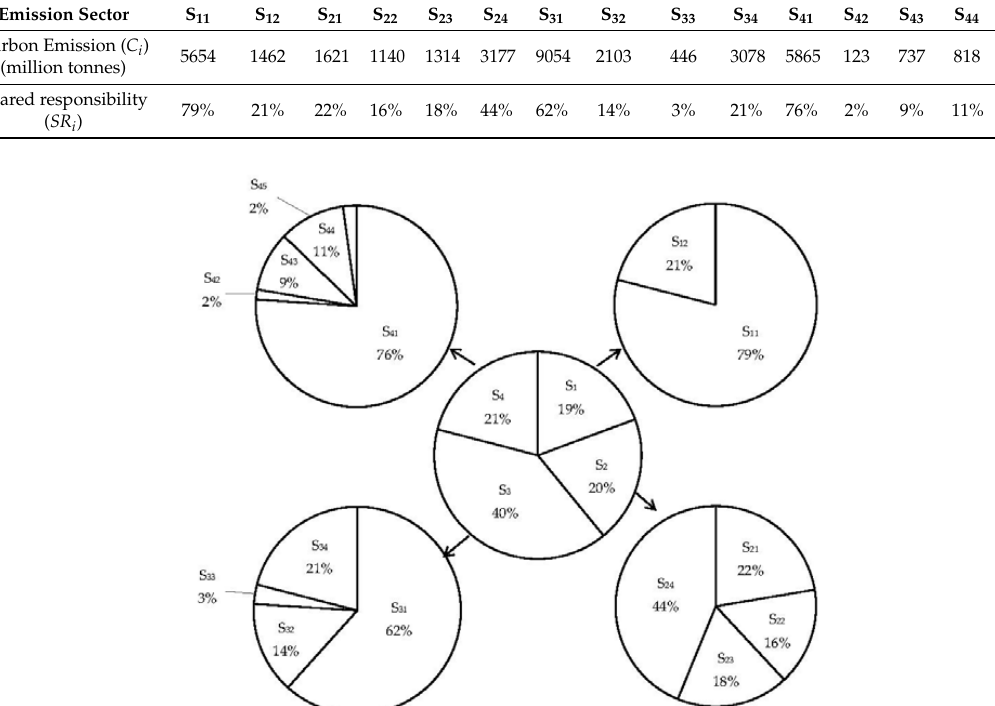
Table 6. The shared responsibility between sub-sectors.